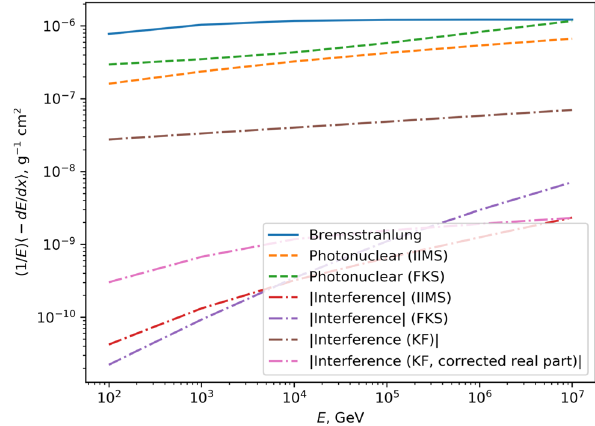
Fig. 3 Bremsstrahlung, photonuclear, and interference energy loss of muons on oxygen